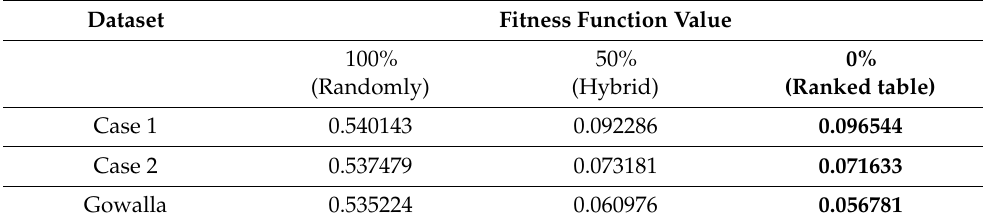
Table 8. The results of the fitness function values when varying the initialization mechanisms.